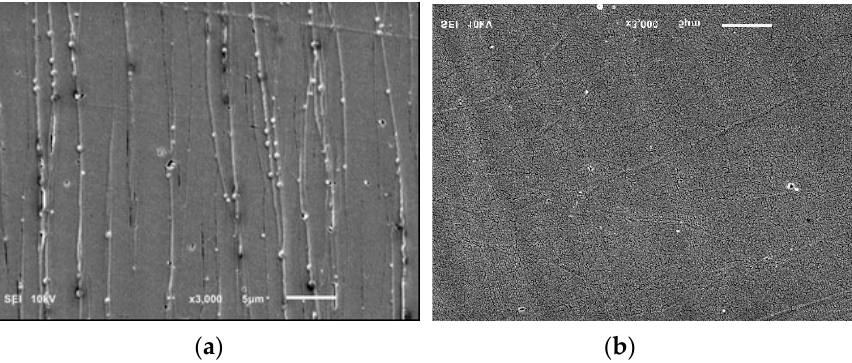
Figure 4. SEM images of ultramicrotomed surfaces of in situ generated PLA/PHA composites. ( a ) transverse, ( b ) longitudinal sections.